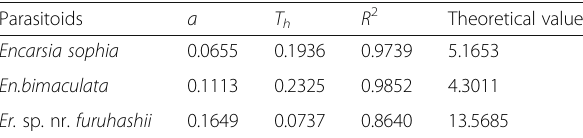
Table 3 Function response parameter of parasitoids in